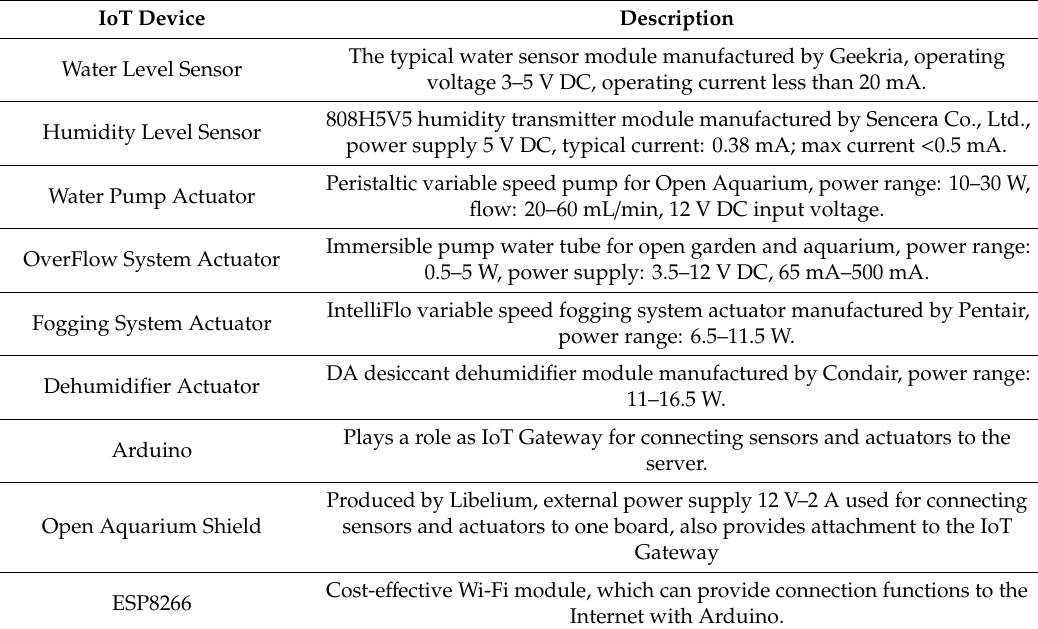
Table 6. Description of IoT devices for the experimental hydroponics